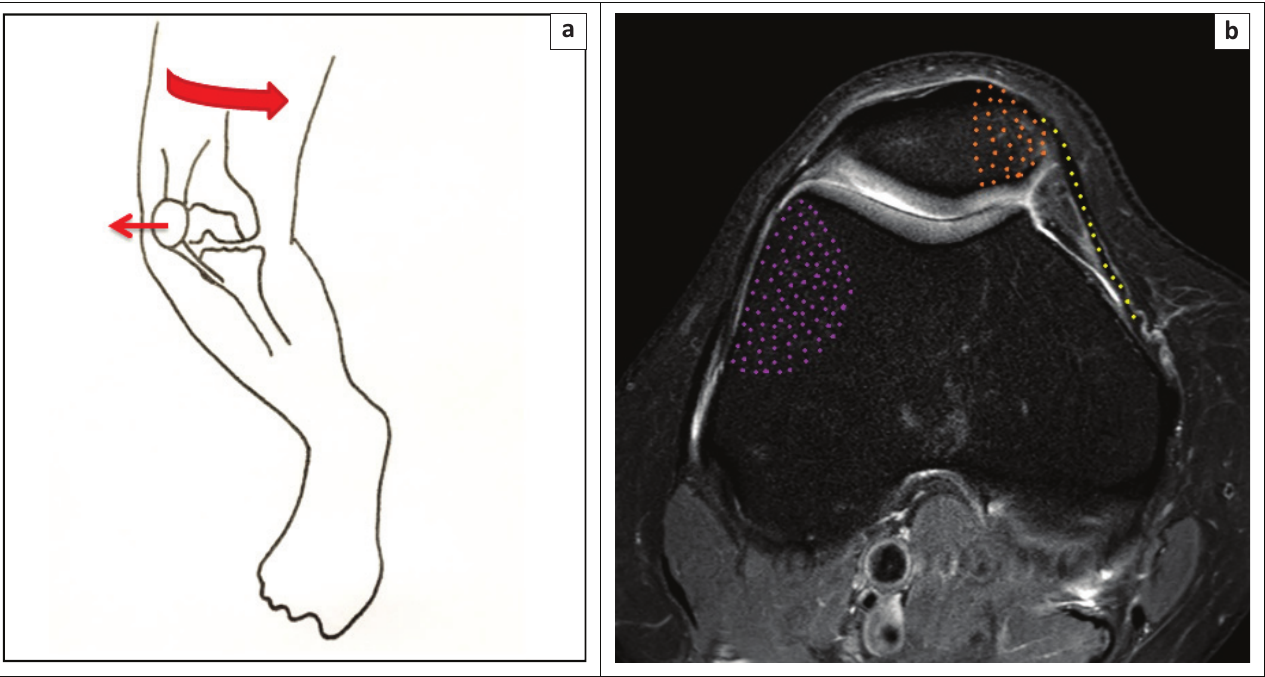
FIGURE 8: Flexion, with posterior tibial translation: (a) Schematic depicts direct posterior force on flexed tibia (no bone bruise unless severe force or associated with axial load) and (b) posterior cruciate ligament injury; posterior dislocation can occur with severe force.